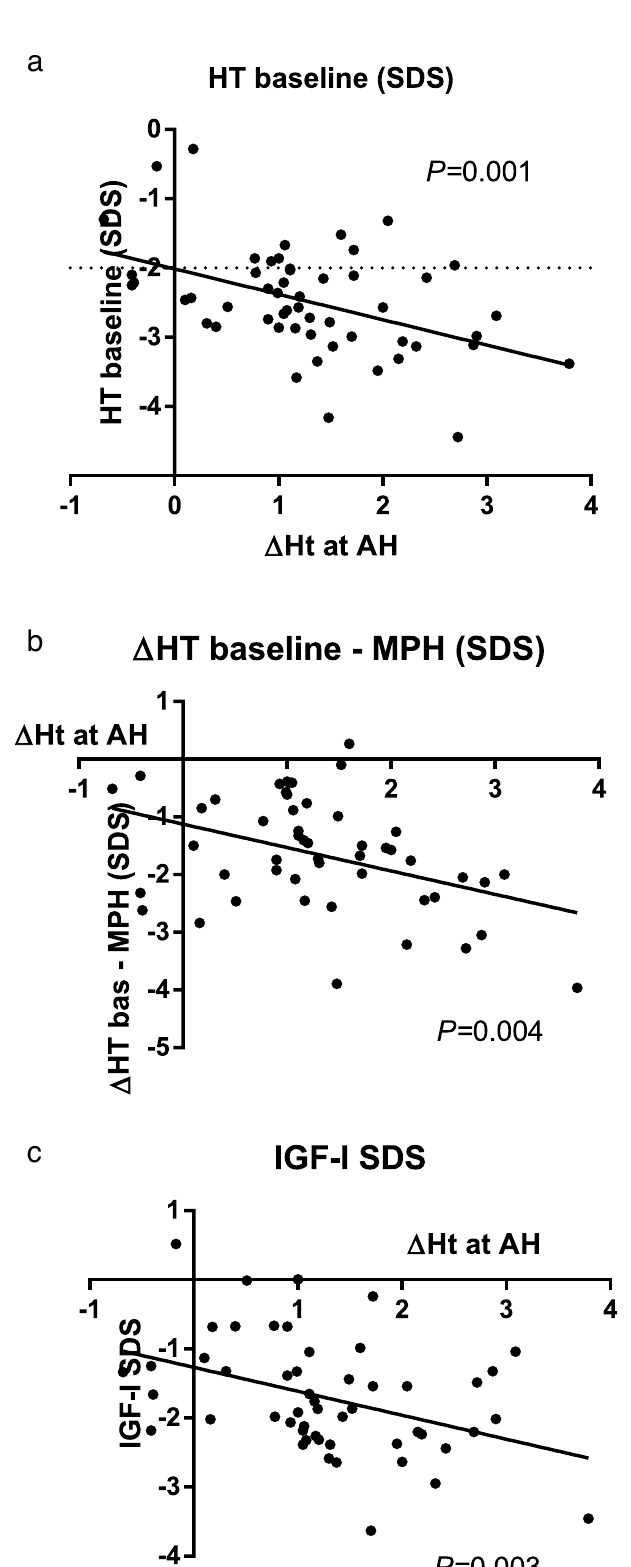
Figure 5. Correlations between height gain (∆HT) at adult height (AH) and ( a ) height SDS at baseline; ( b ) mid-parental height (MPH) difference at baseline expressed as height SDS; ( c ) insulin-like growth factor-I (IGF- I) at